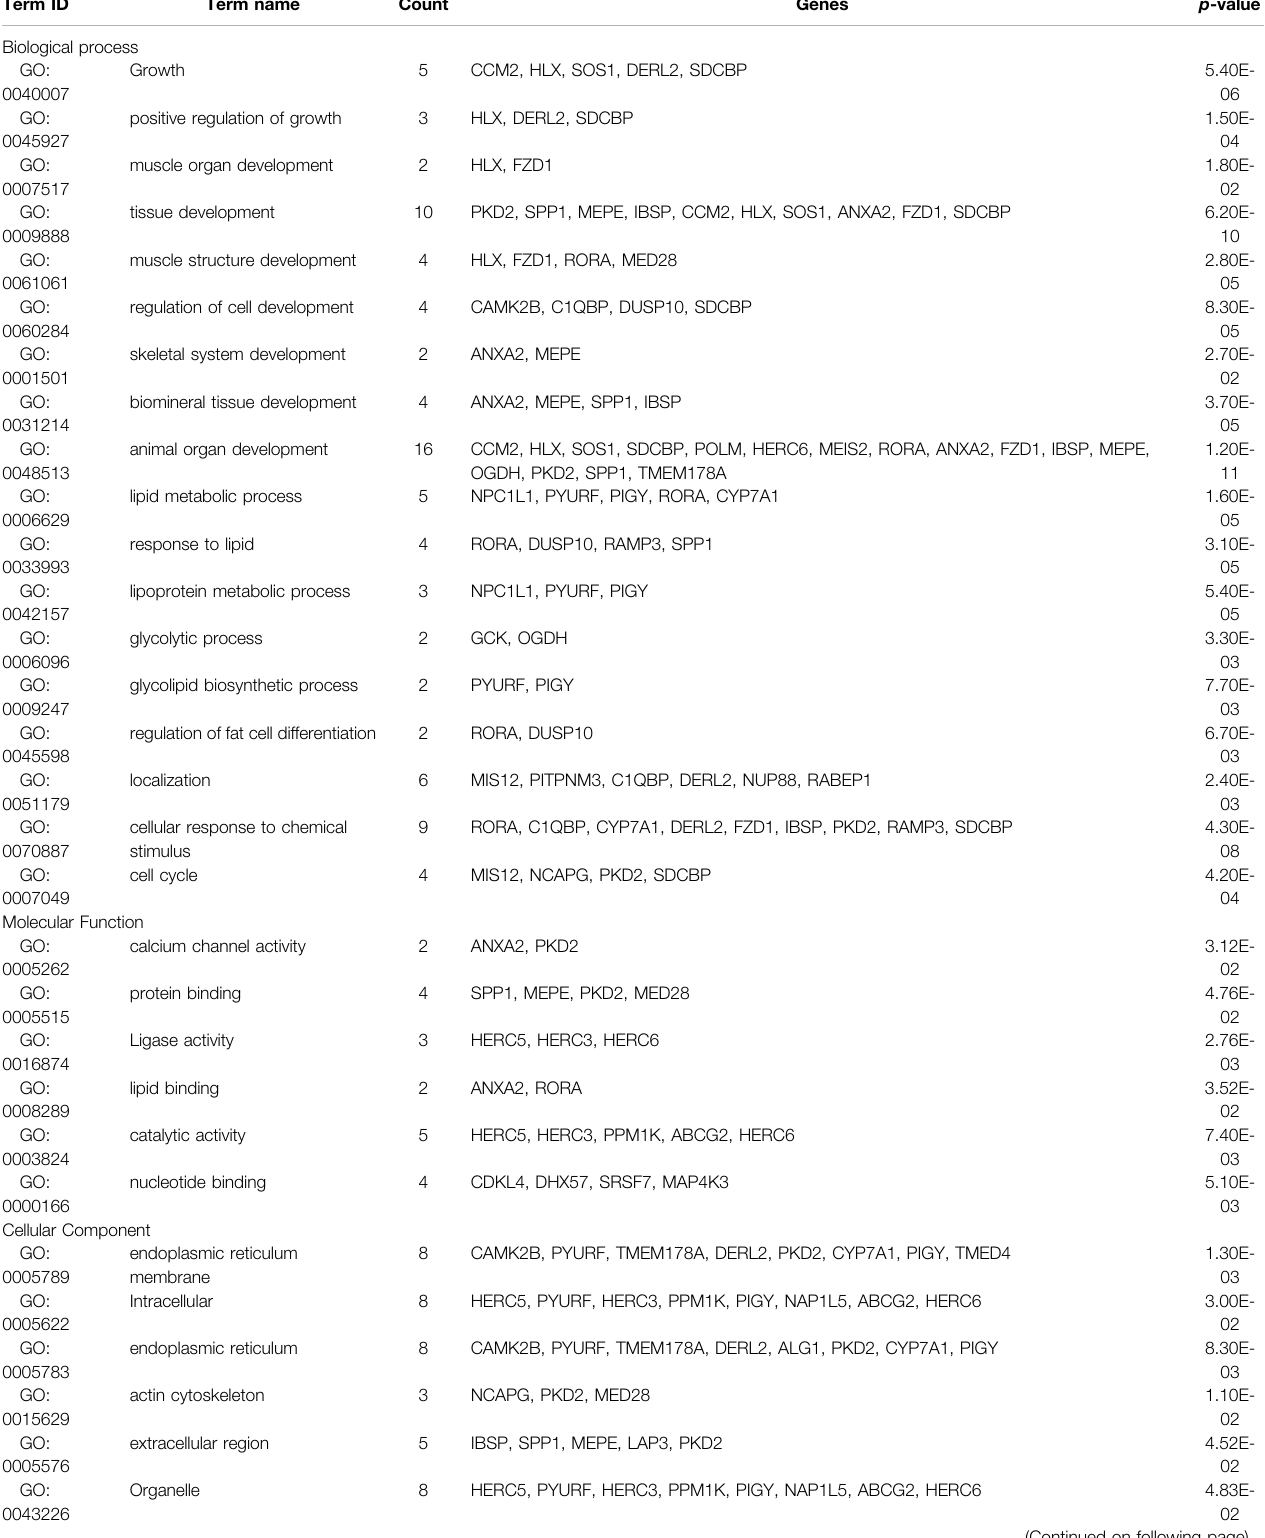
TABLE 3 | Gene Ontology (GO) terms and KEGG pathways signi fi cantly enriched using candidate genes associated with the primal cut